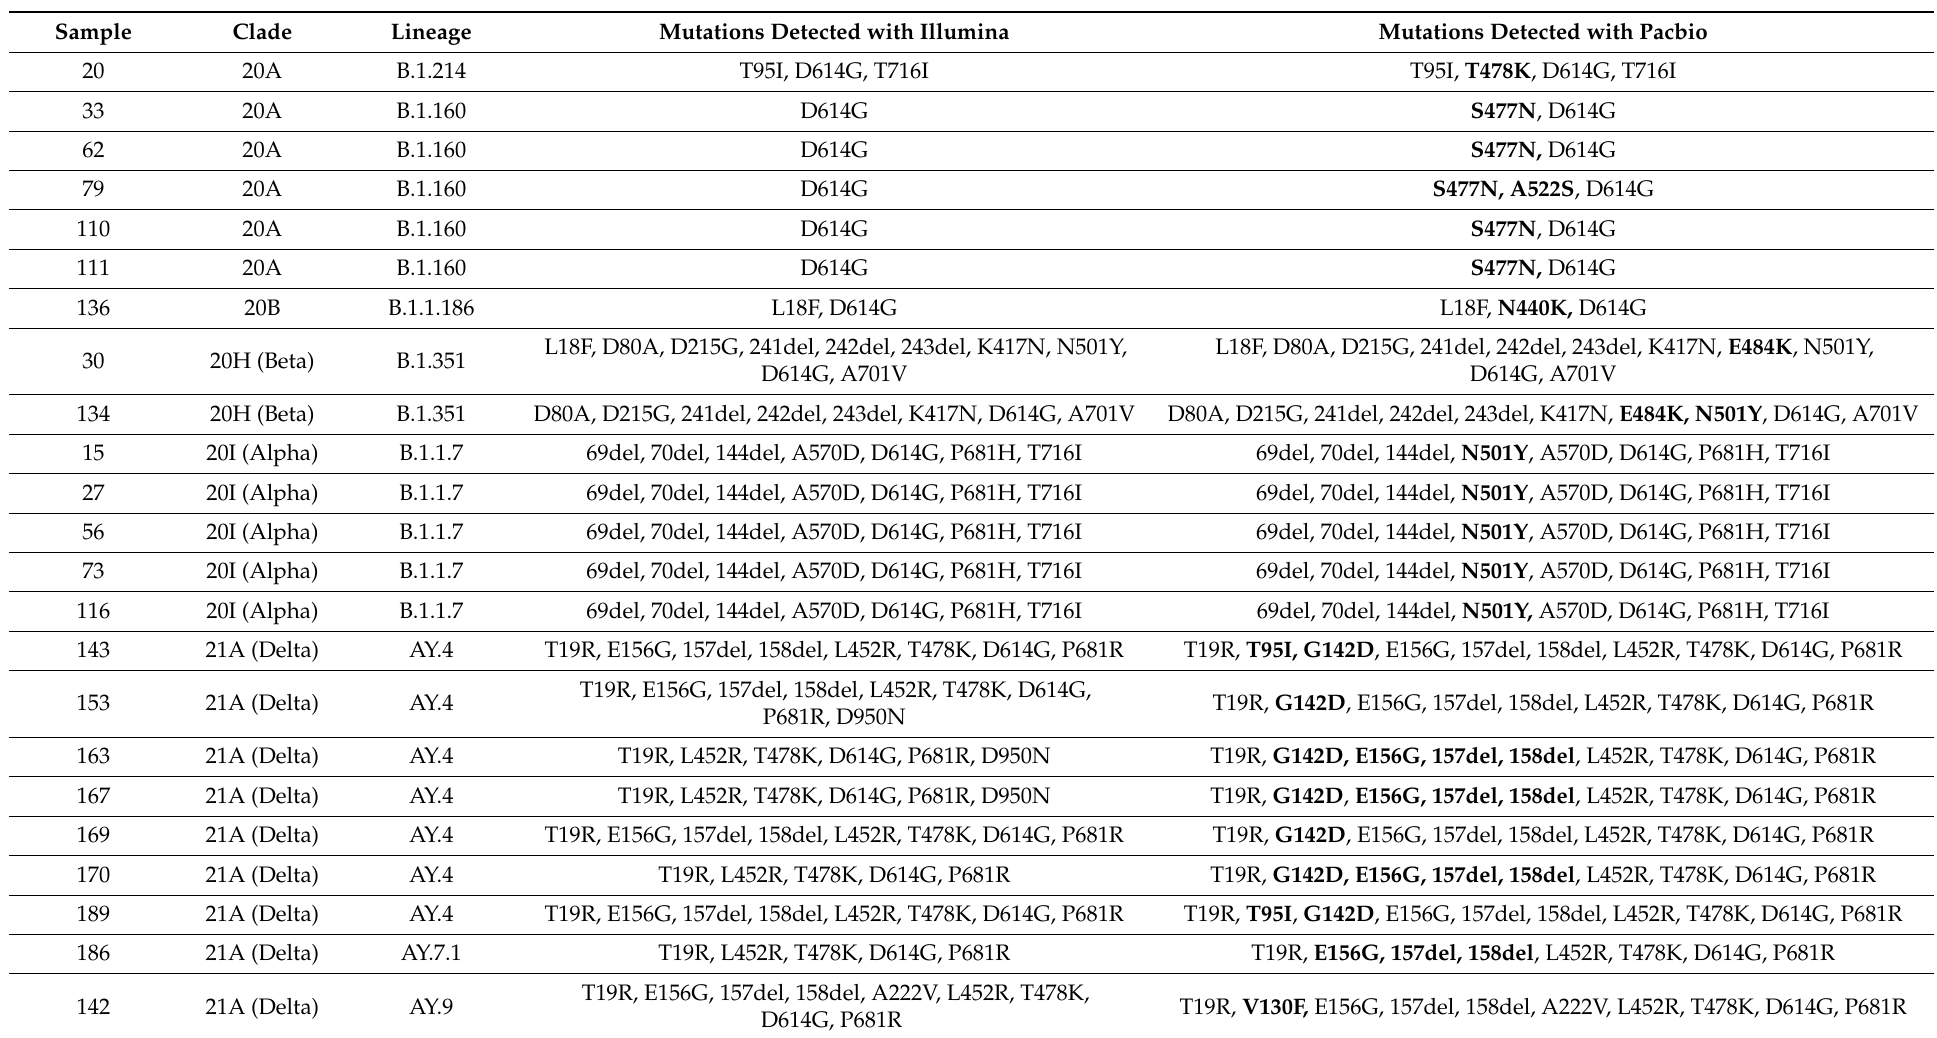
Table 3. List of mutations detected with the Illumina and PacBio SMRT systems in 14 patient samples giving discrepant